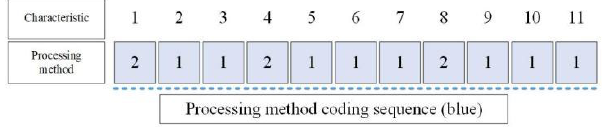
Figure 3. Encoding sequence of machining method layer.